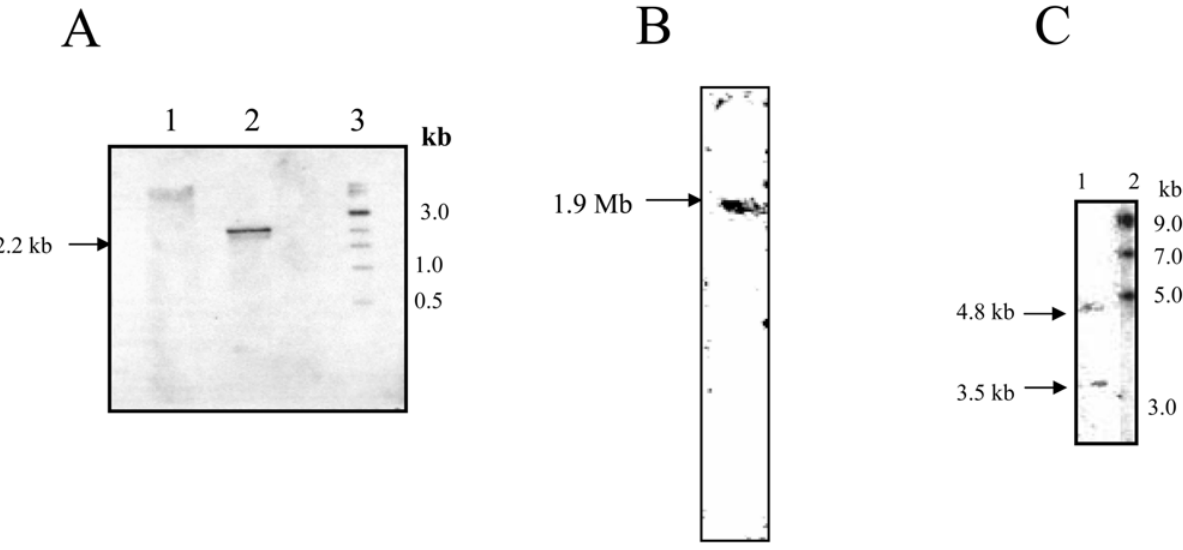
Figure 3. Southern blot analysis of E.histolytica putative ODC -like gene. (A) Lanes 1 and 2, restriction digest of E. histolytica genomic DNA with XhoI and HindIII, respectively. Lane 3 represents the DNA molecular weight marker and sizes are indicated on the right of the figure. The blot was probed with 1,242 bp full-length putative ODC -like gene. (B) PFGE analysis of E. histolytica indicating chromosomal localization of the ODC gene. The blot was probed with the putative ODC-like gene probe. The arrow shows a 1.9 Mb hybridizing band of putative ODC. (C) Northern blot analysis of mRNA from E. histolytica. Lane 1, total RNA from E. histolytica probed with 1,242 bp full-length putative ODC -like gene; lane 2, molecular weight marker.